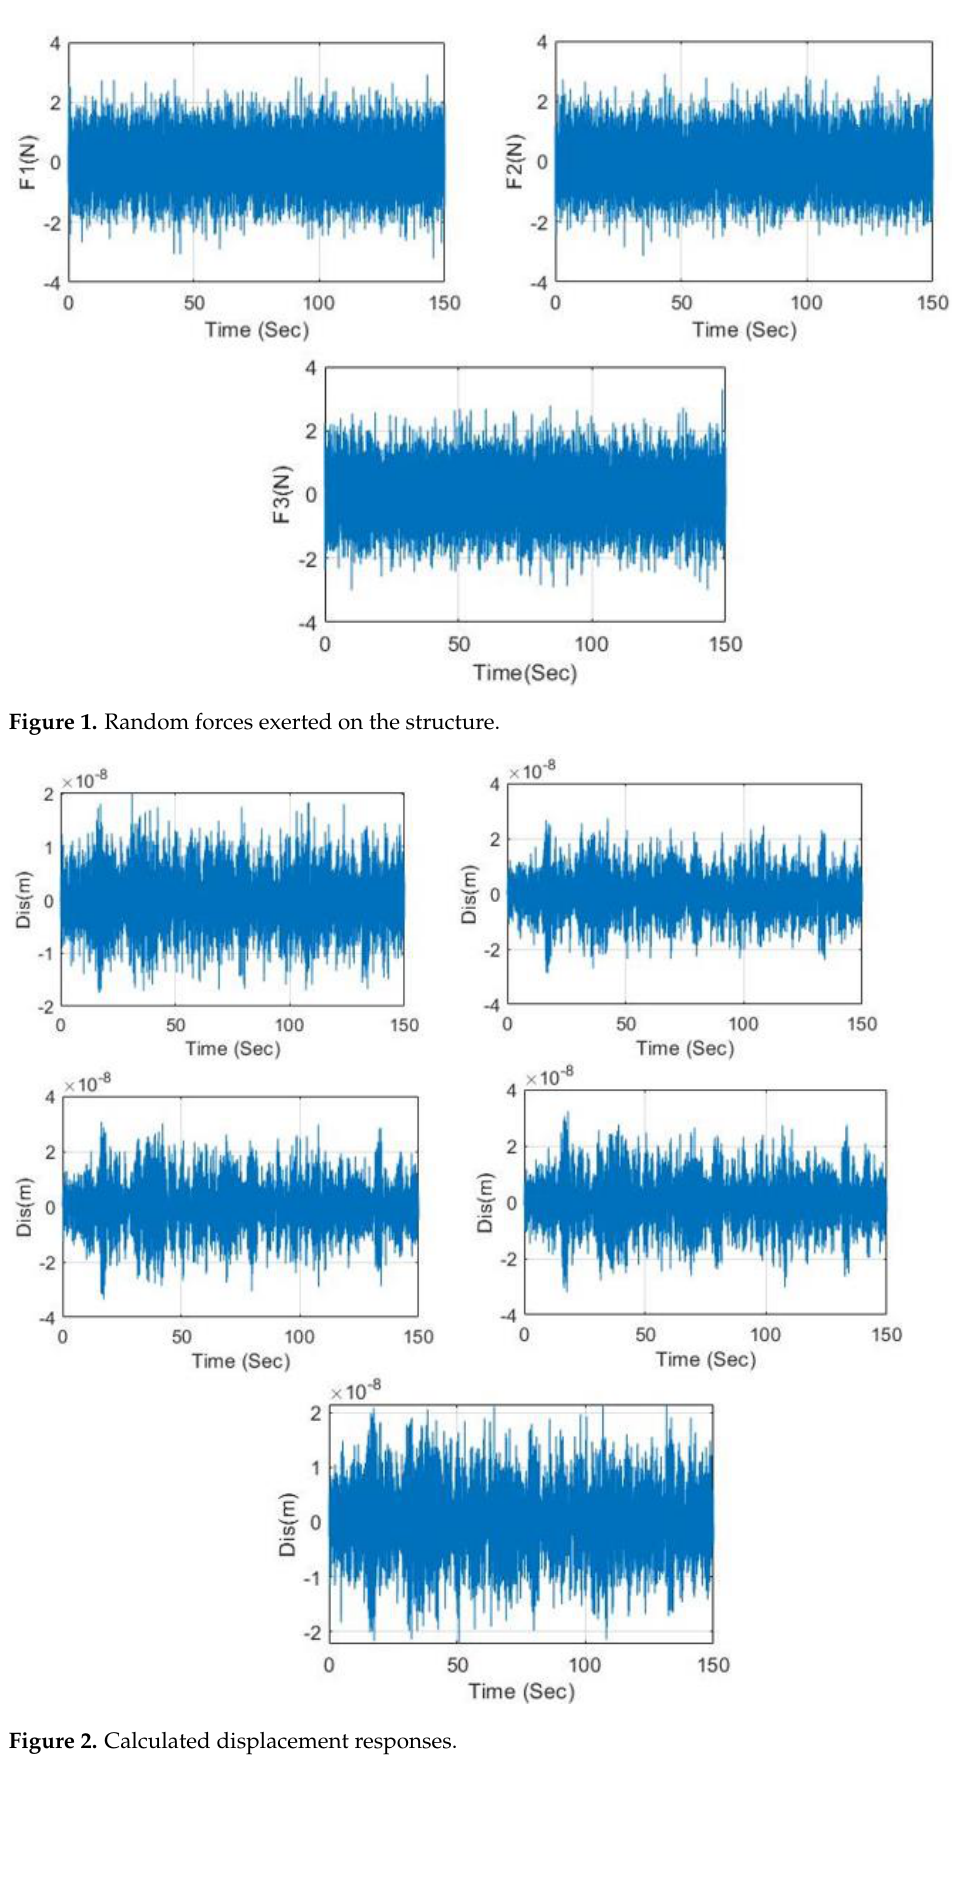
( c ) Figure 3. Estimation of the random forces. ( a ) Force 1; ( b ) force 2; ( c ) force 3.